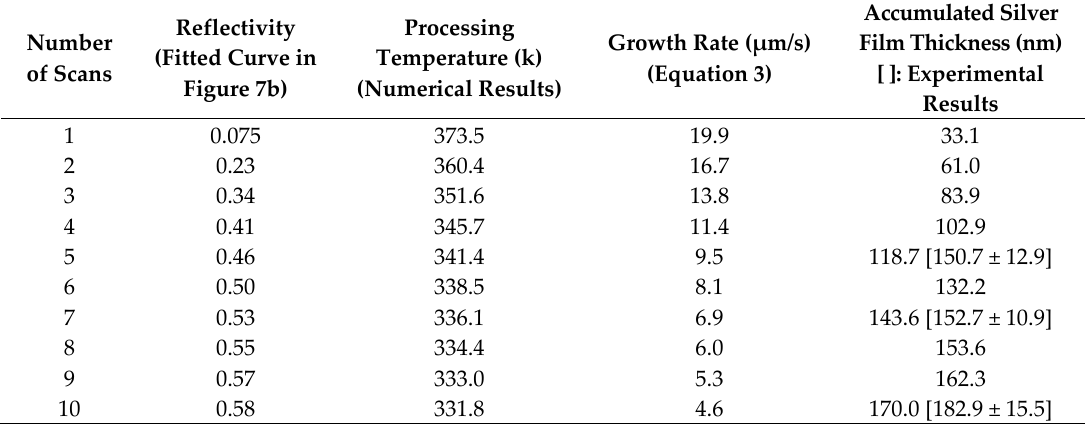
Table 1. Evaluation for the proposed model for laser direct synthesis and patterning (LDSP) process analysis processing parameters: (laser power: 200 mW, scanning speed: 30 mm/s, processing solution: ethylene glycol based solution (at a volumetric ratio